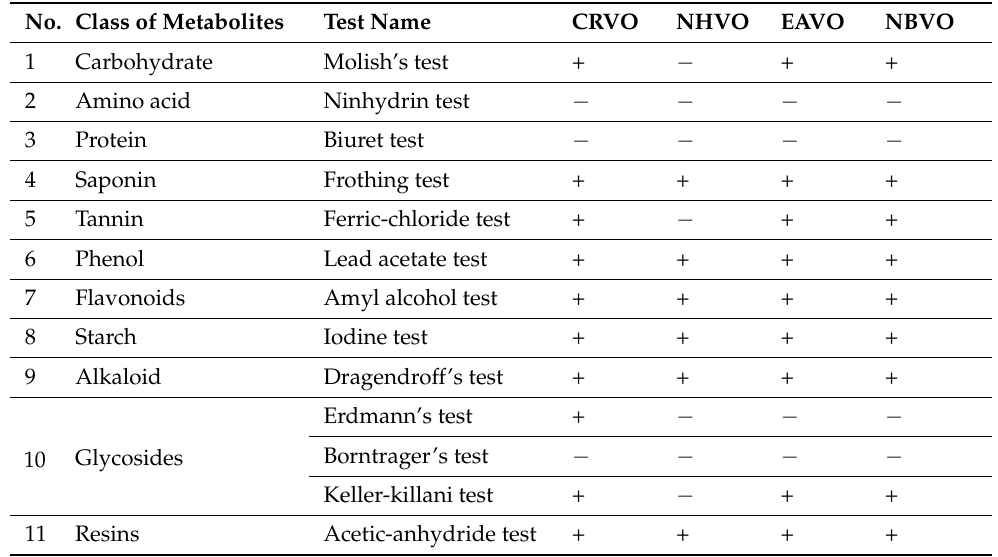
Table 1. Preliminary phytochemical assessment of the methanolic crude extract of Verbena officinalis and its different